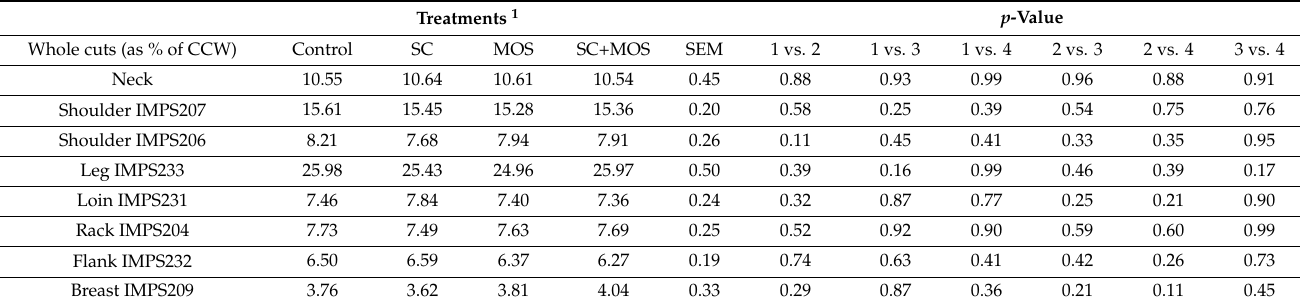
Table 5. Effect of treatments on whole cuts of finishing lambs supplemented for 93 days with eubiotics alone or combined. Treatments 1 p -Value Whole cuts (as % of CCW) Control SC